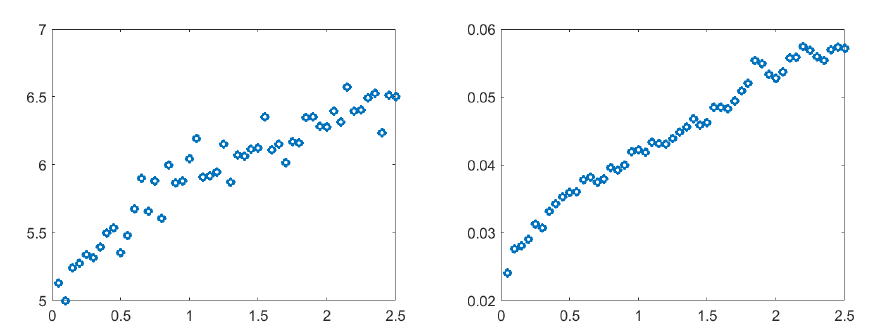
Figure 10. Calculated sample MSD as a function of time lag ( τ ) for concentration c 1 . Two cases are presented: ( left ) intermolecular; ( right ) intramolecular.